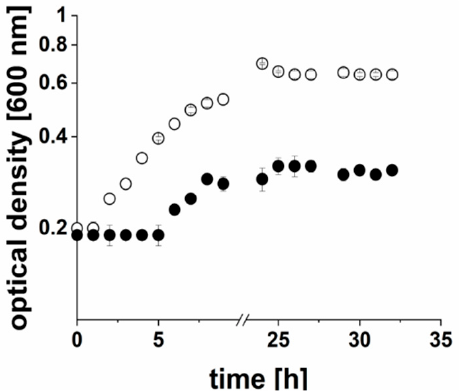
Figure 4. Effect of (NH 4 ) 2 SO 4 on the growth of P. bivia . Cells were cultivated with 7 mM of (NH 4 ) 2 SO 4 (white circles) or 80 mM of (NH 4 ) 2 SO 4 (black circles) at pH 6. Average and standard deviations of three biological replicates are shown.